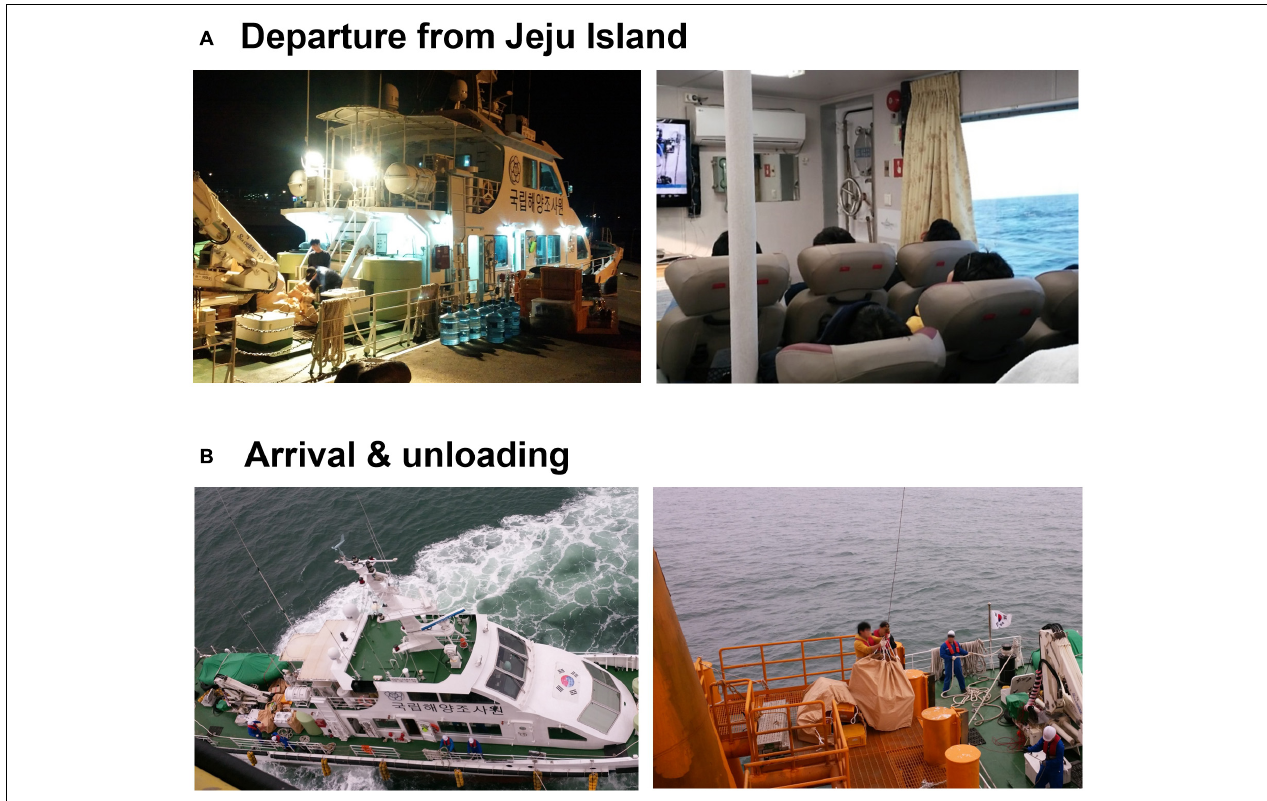
FIGURE 4 | Images showing (A) departure from Jeju Island; the ship travel environment; and (B) arrival at Ieodo ORS, through the field trip program run by the Korea Hydrographic and Oceanographic Agency.